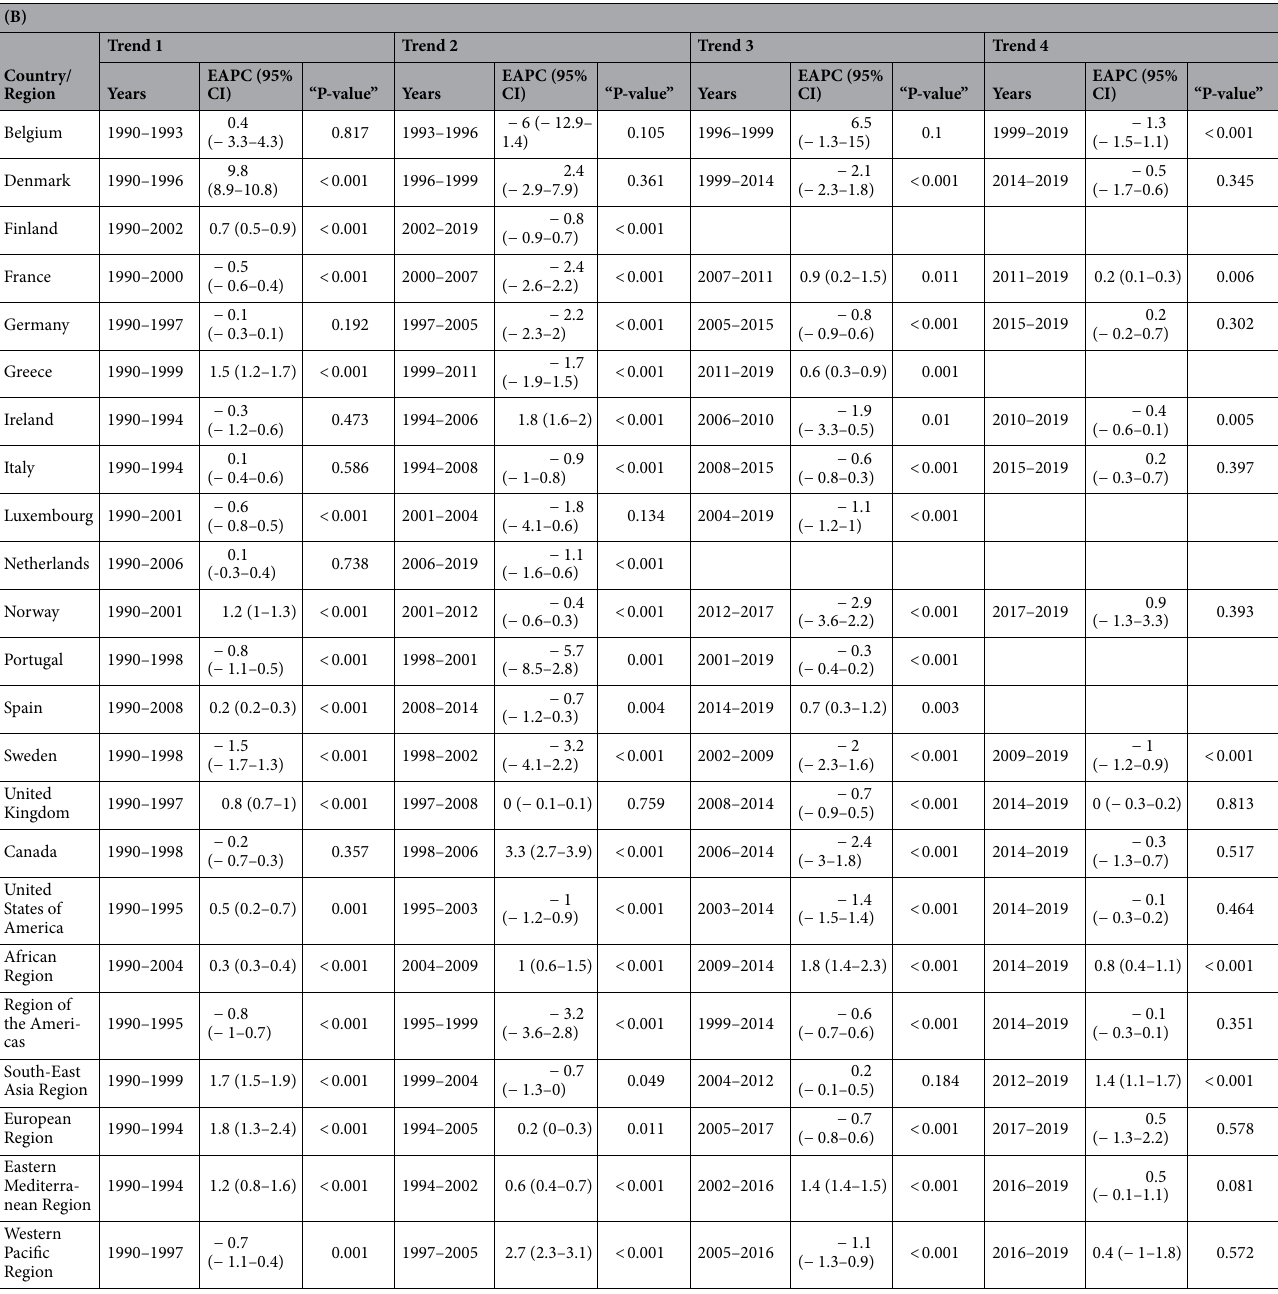
Table 5. Joinpoint analysis for KC age-standardized DALYs in EU15 + countries and WHO regions for years 1990–2019 for both sexes. EAPC indicates estimated annual percentage change, with 95% confidence